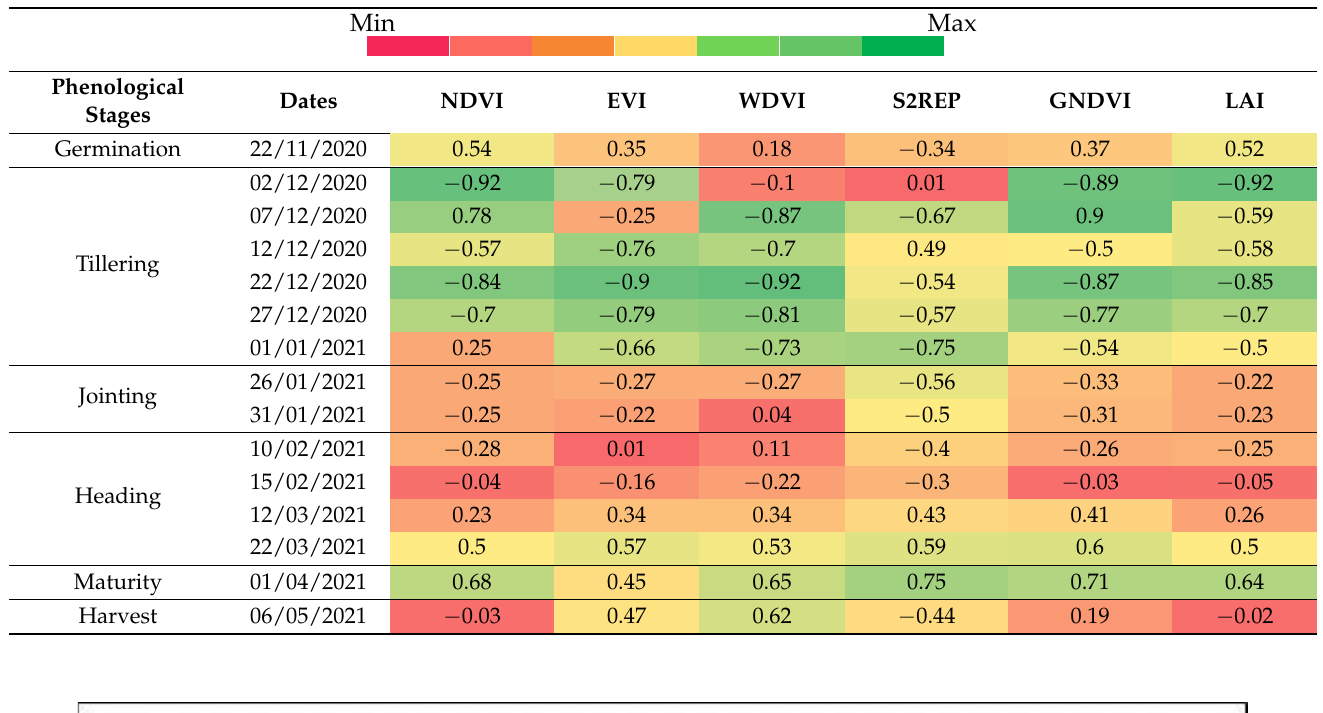
Table 3. Pearson’s Correlation coefficient between remote sensing indices and wheat yield in the different phenological stages.